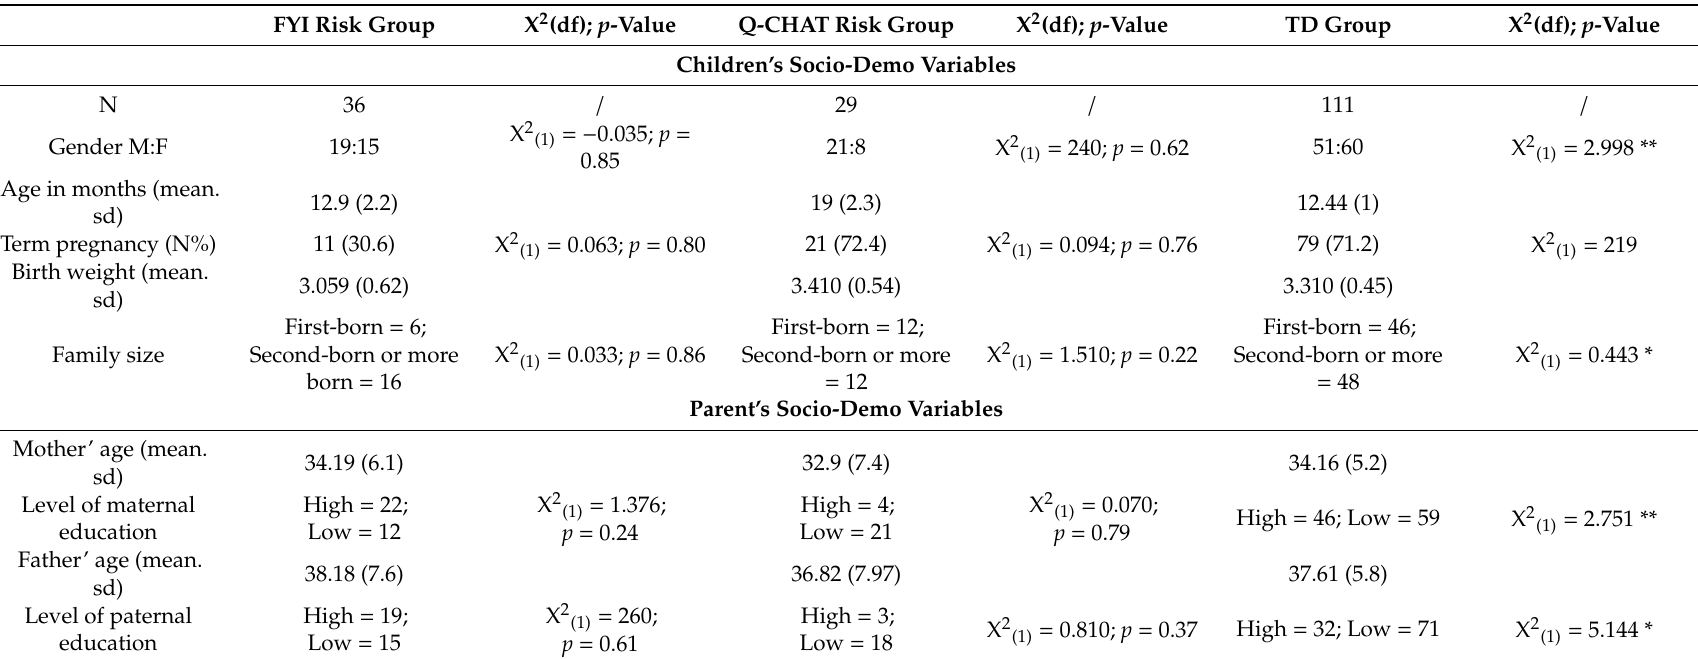
Table 1. Comparison between risk groups and typically developing